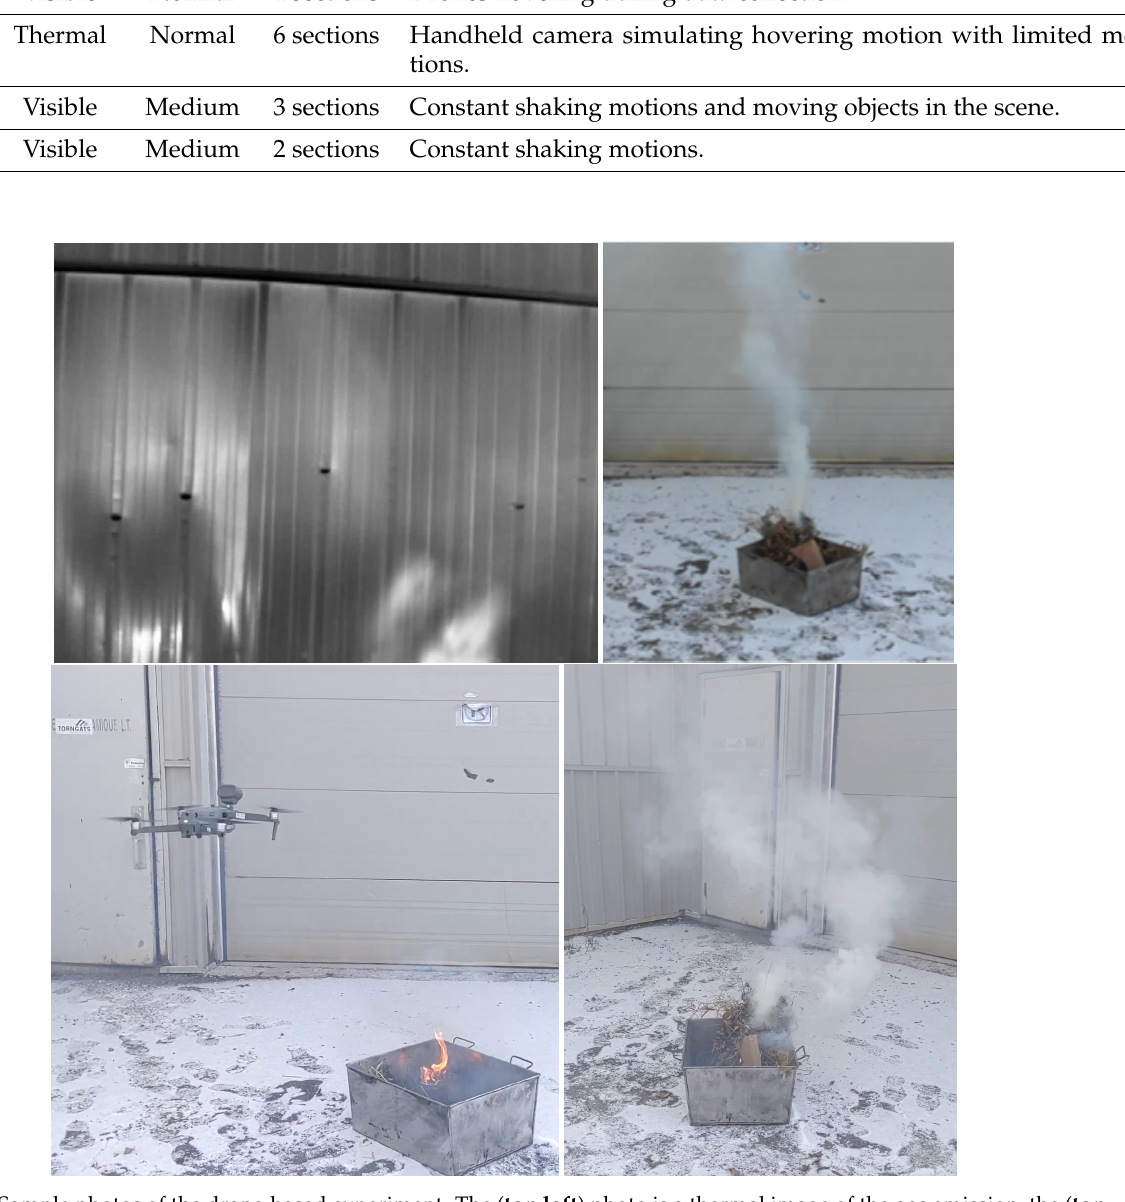
Figure 5. Sample photos of the drone-based experiment. The ( top left ) photo is a thermal image of the gas emission, the ( top right ) photo is a visible image collected by drone; the ( bottom left ) is a photo of the drone during the experiment and the ( bottom right ) is another photo sample of collected imagery data by drone.